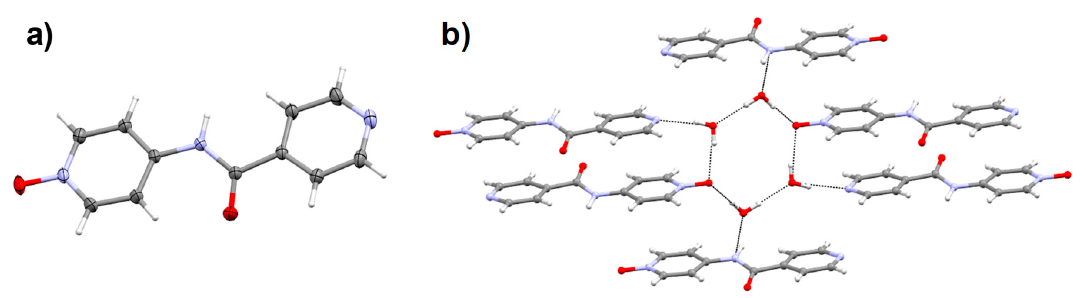
Figure 5. Single-crystal structure of PNO : ( a ) Asymmetric unit (water molecules not shown); ( b ) two- dimensional (2-D) sheet constructed by H-bonding between the ligand and solvent (water) molecules.